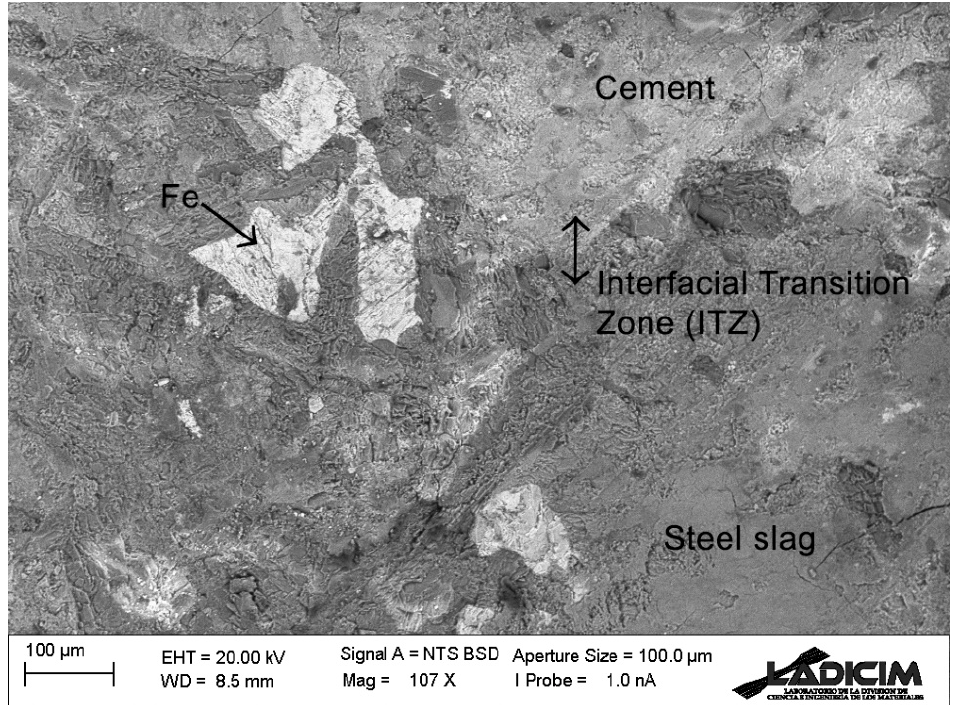
Figure 14. Encounter of cement and EAFS aggregate in the interfacial transition zone. Figure 15. Encounter of cement and EAFS aggregate in the interfacial transition